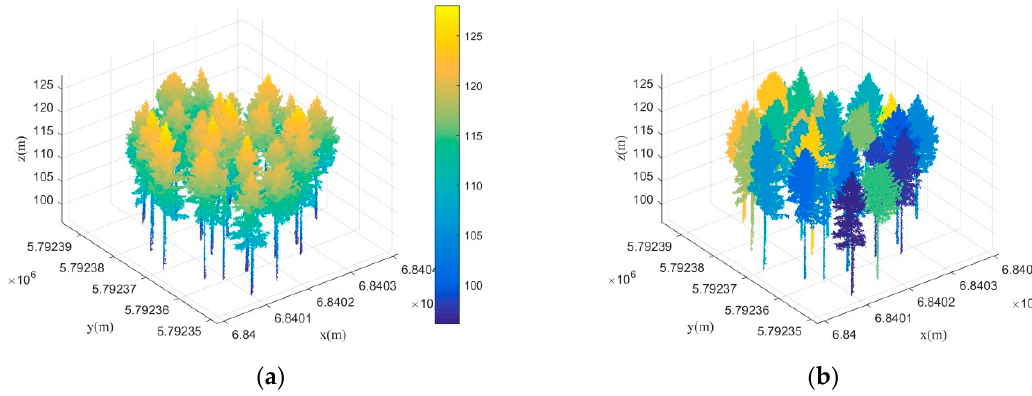
Figure 18. Tree point cloud and its segmentation results. ( a ) Tree point clouds scanned by the Riegl VZ-400 terrestrial laser scanner; ( b ) segmented individual trees by the proposed method. Each segmented tree is random colored.